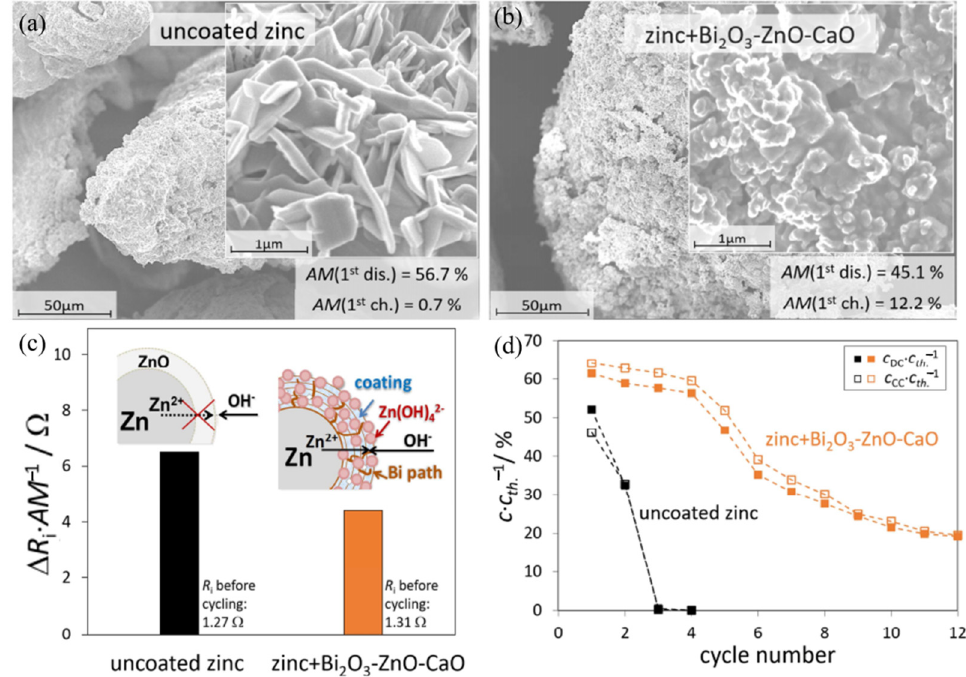
Figure 10. SEM micrograph of bare zinc ( a ) and coated zinc ( b ); ( c ) ohmic resistance ∆ Ri , depends on active zinc utilization AM, of bare zinc and zinc covered with 3.2 wt.% Bi 2 O 3 -ZnO-CaO, together with the graphic representation of passivation behavior of the zinc particles; and ( d ) cyclic performance of zinc–air batteries utilizing bare and coated zinc [48]. Reprinted with permission from Ref. [48], Copyright 2018, Elsevier.